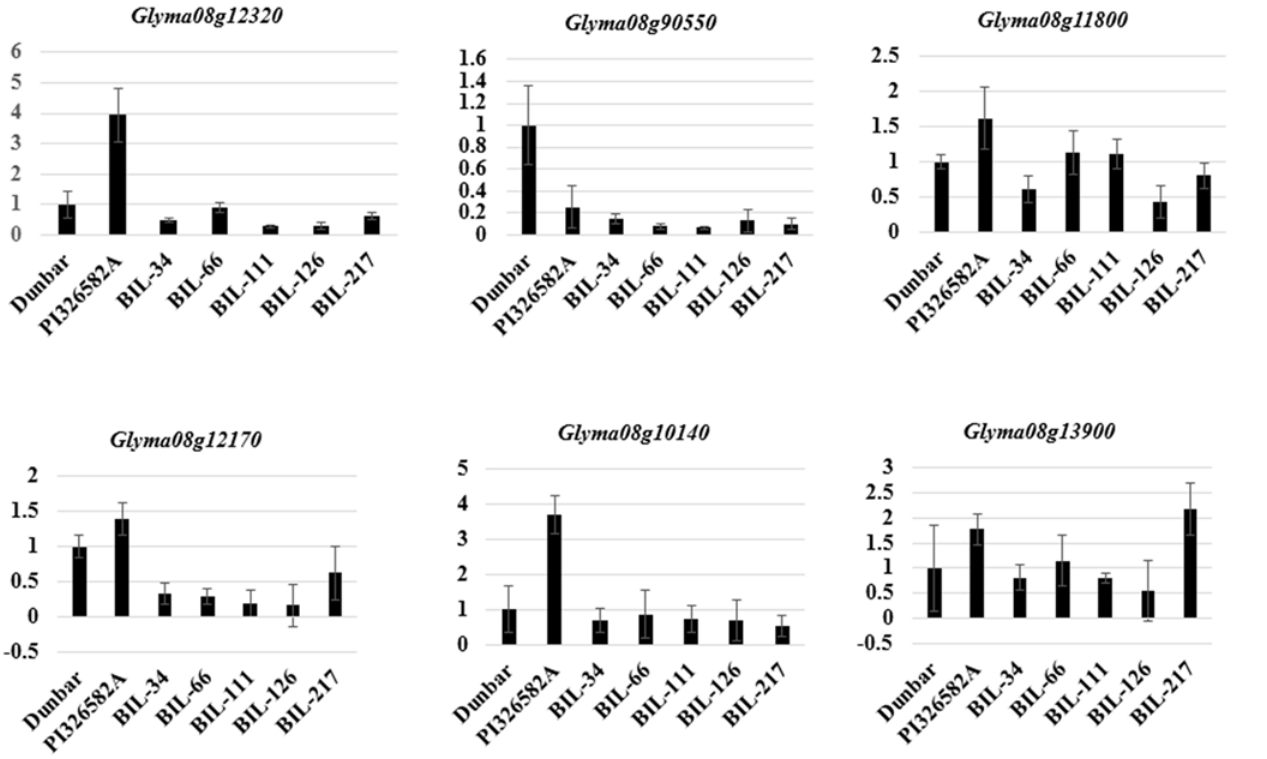
Fig 7. Differential expression of key transcription factors identified in the QTL interval on chromosome